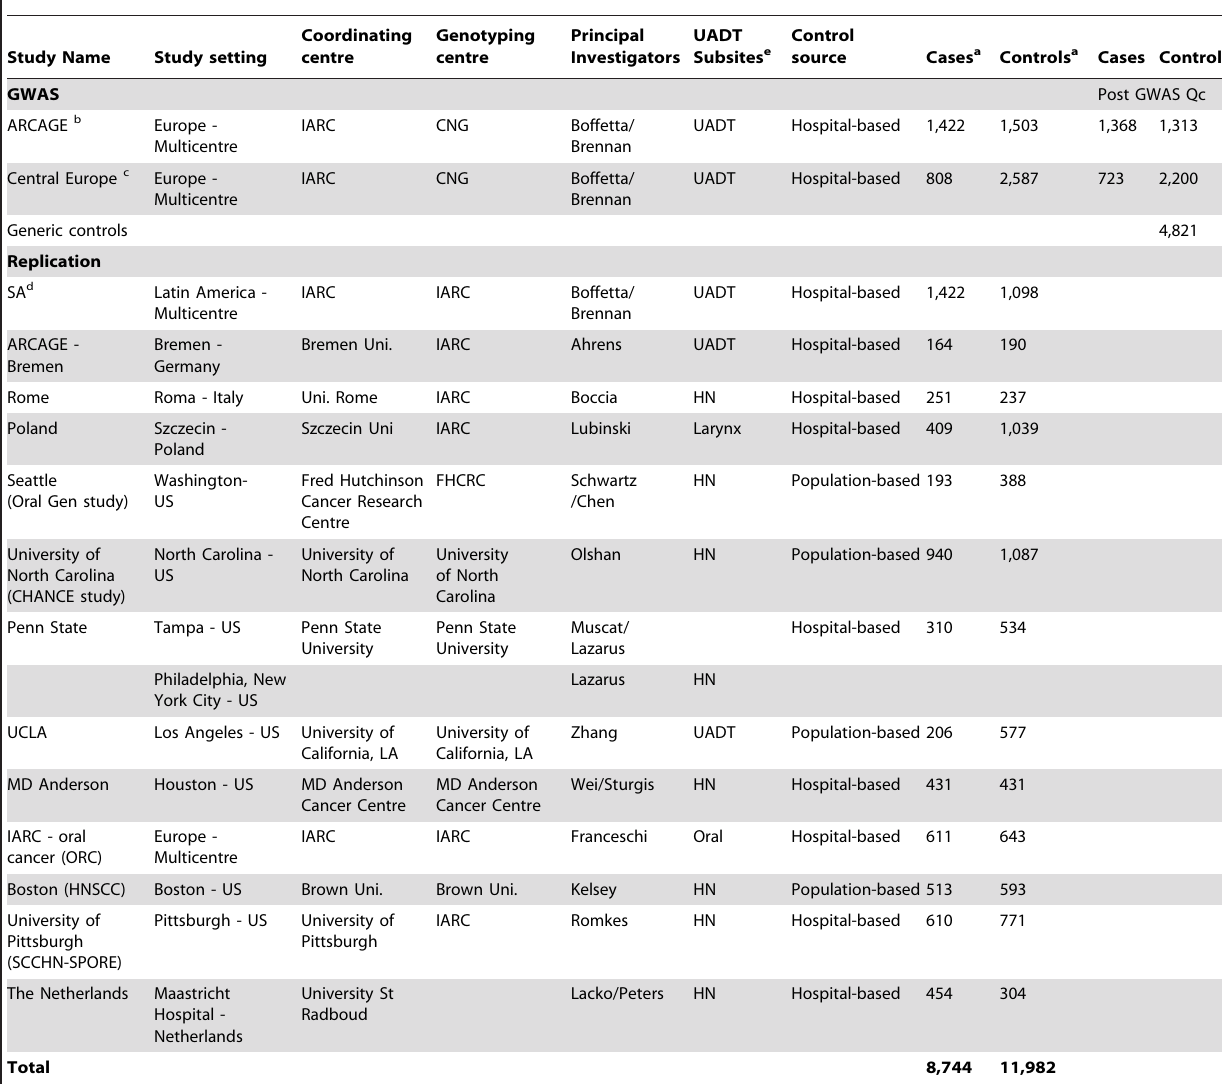
Table 4. The 15 UADT cancer studies participating in the genome-wide and replication